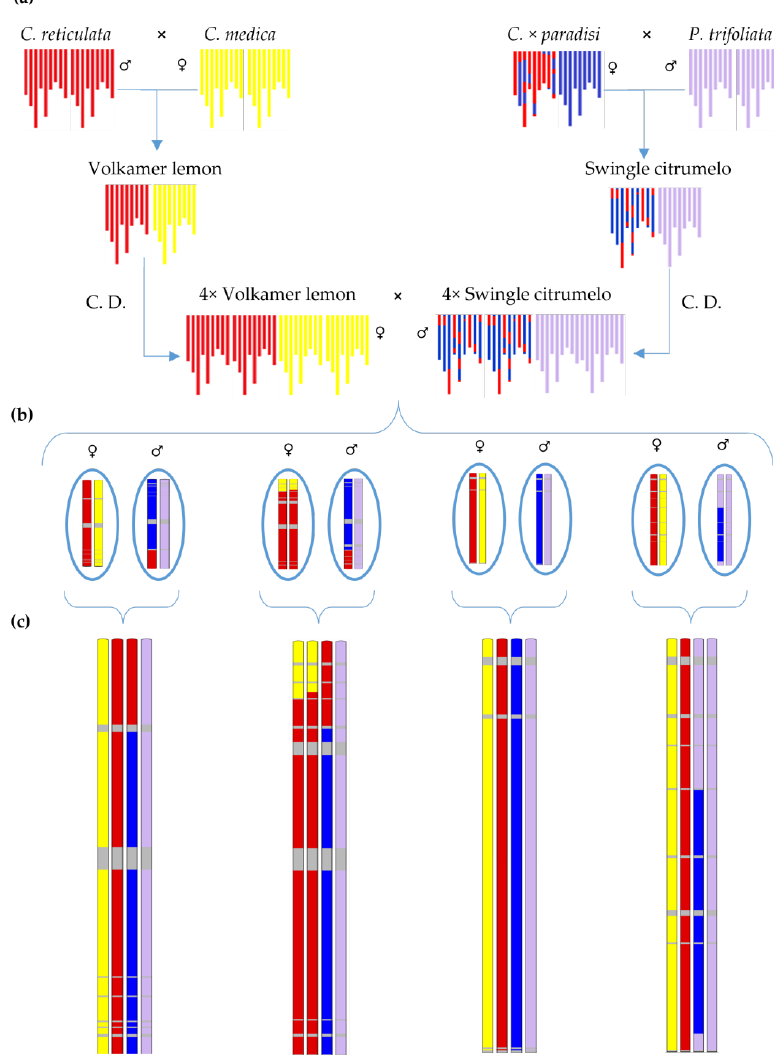
Figure 7. Phylogenomic structure of tetraploid parents and inference of phylogenomic structure of tetrazyg hybrids. ( a ) Origin and phylogenetic karyotypes of the tetraploid parents used in this paper. ( b ) Examples of Volkamer lemon ovule and Swingle citrumelo pollen phylogenetic structure for chromosome 1 and ( c ) examples of phylogenetic structure of chromosome 1 for four intergeneric Volkamer lemon × Swingle citrumelo tetraploid hybrids. C.D.: chromosome doubling of nucellar cells. Ancestral genome contribution: C. reticulata (red), C. maxima (blue), C. medica (yellow), P. trifoliata (purple), indeterminate area